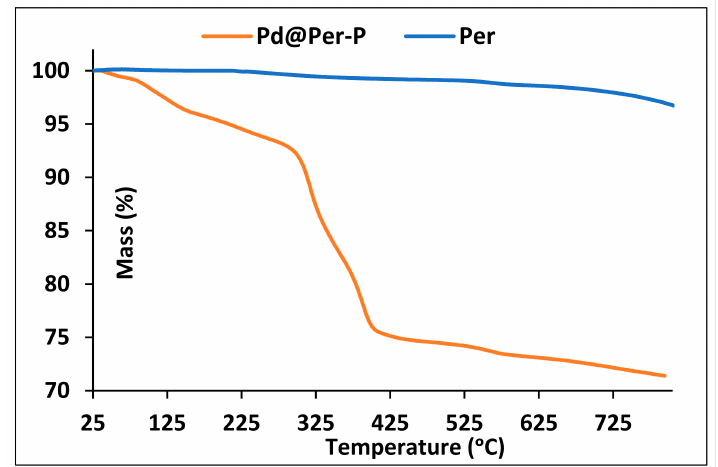
Figure 8. TG curves of Per and Pd@Per-P.